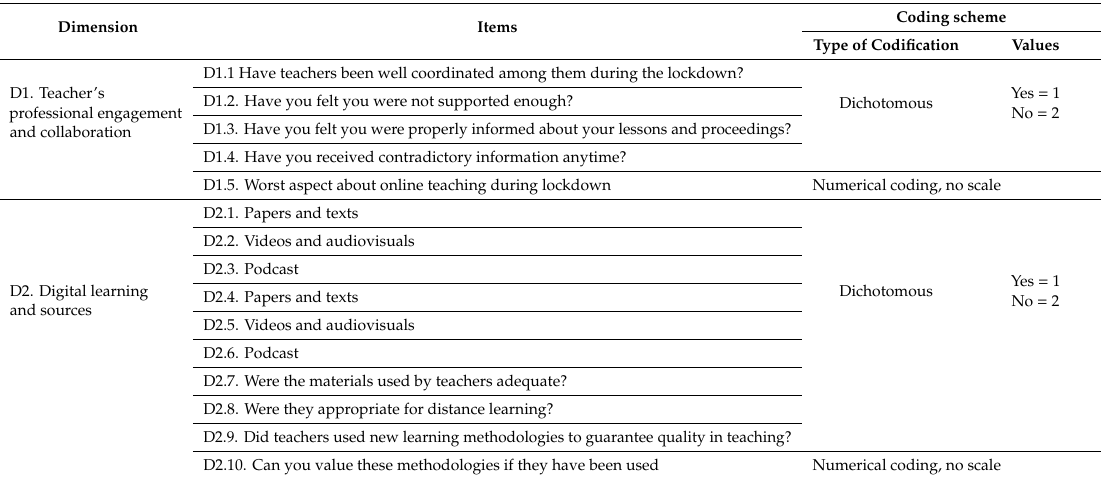
Table A1. Dimensions, items in each dimension and coding scheme used in the